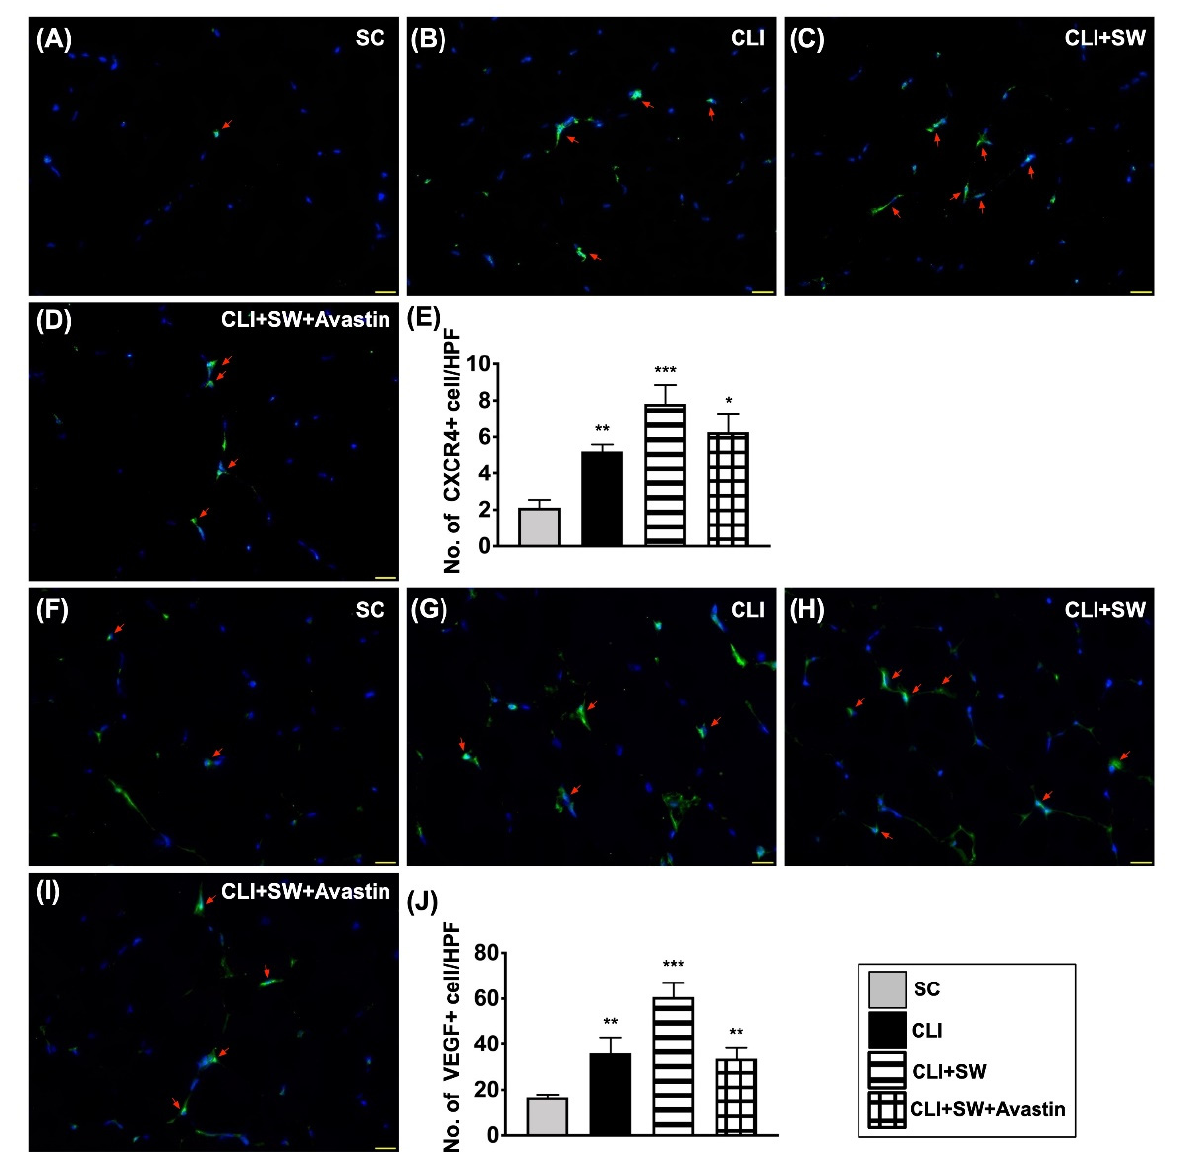
Figure 8. Cellular expressions of angiogenesis in CLI quadriceps muscle by day 14 after CLI induction. ( A–D ) Illustrating the immunofluorescent (IF) microscopic finding (400×) for identification of cellular expression of CXCR4 (green color, red arrows). ( E ) Analytical result of number of CXCR4+ cells, * for p < 0.05, ** for p < 0.01, *** for p < 0.001. ( F–I ) Illustrating the IF microscopic finding (400×) for identification of cellular expression of vascular endothelial growth factor (VEGF) (green color, red arrows). ( J ) Analytical result of number of VEGF+ cells, * for p < 0.05, ** for p < 0.01, *** for p < 0.001. All scale bars in right lower corner represent 20 μ M. HPF = high-power field. n=6 for each group. SC = sham-operated control; SW = shock wave.